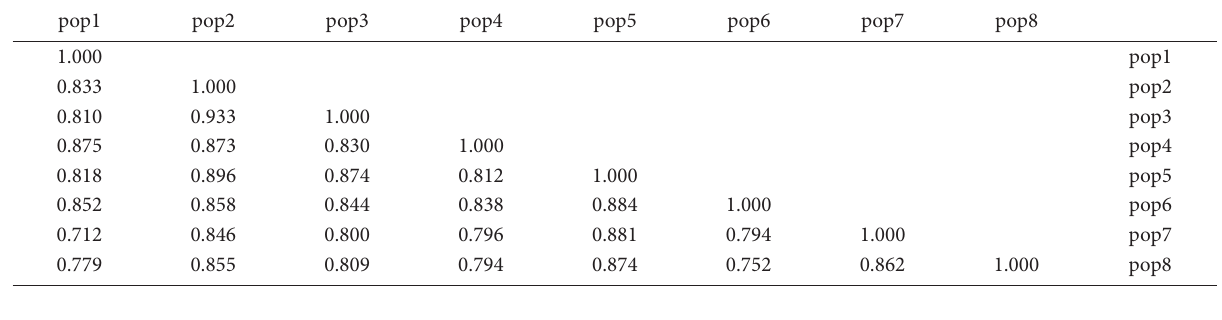
Table 5. Pairwise Population Matrix of Nei Unbiased Genetic Identity.